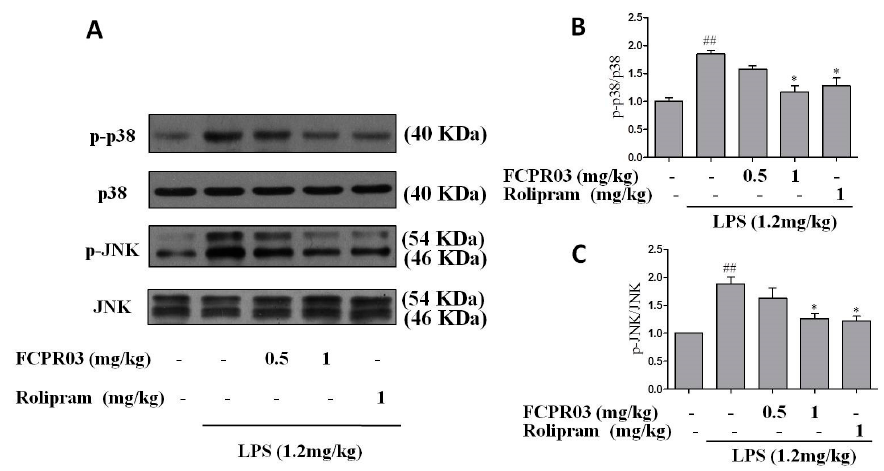
Figure 8. FCPR03 attenuated the phosphorylation of p38 and JNK in hippocampus in mice challenged with LPS. After seven consecutive days of pretreatment with FCPR03 (0.5 mg/kg or 1 mg/kg) or rolipram (1 mg/kg), mice were injected i.p. with saline or LPS (1.2 mg/kg, i.p.); 24 h after LPS injection, the entire hippocampal extracts were homogenized, and Western blot was used to assess the phosphorylated p38 (p-p38), total p38, phosphorylated JNK (p-JNK), and total JNK protein levels in the cortex ( A ). The corresponding quantification data are shown in ( B , C ). Data are expressed as the mean ± SEM. ## p < 0.01 compared with control group; * p < 0.05 compared with LPS-treated group ( n = 8 per group).